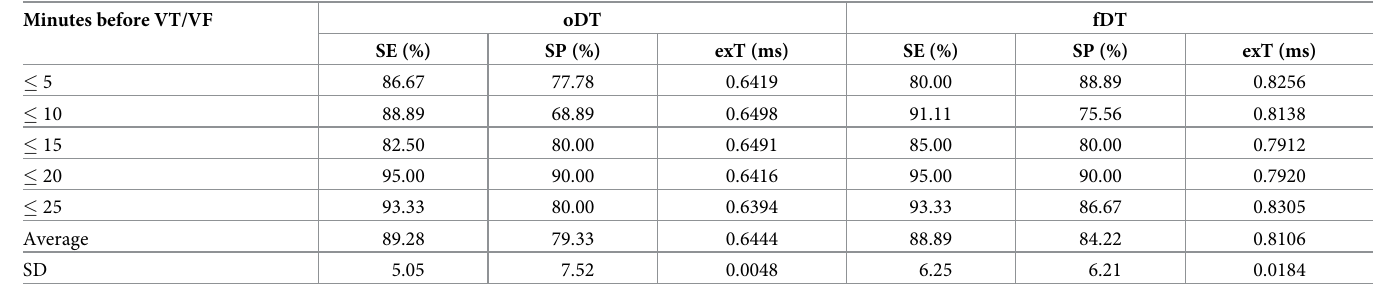
Table 5. Comparison of performance of oDT and fDT.